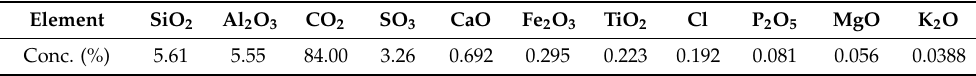
Table 3. Element composition of the clean coal measured by XRF. Conc.—Concentration.